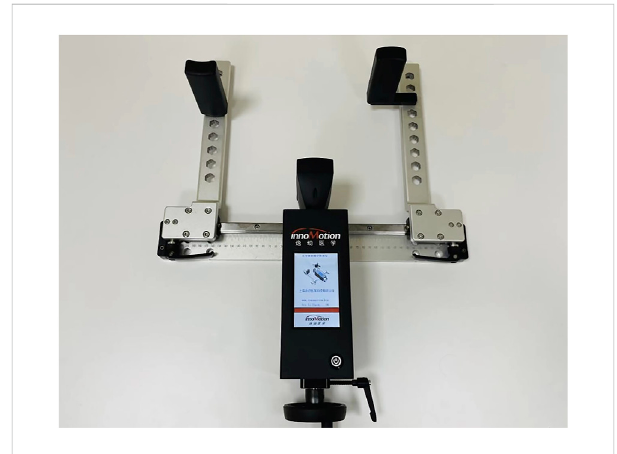
FIGURE 1 The presentation of the Ligs Digital